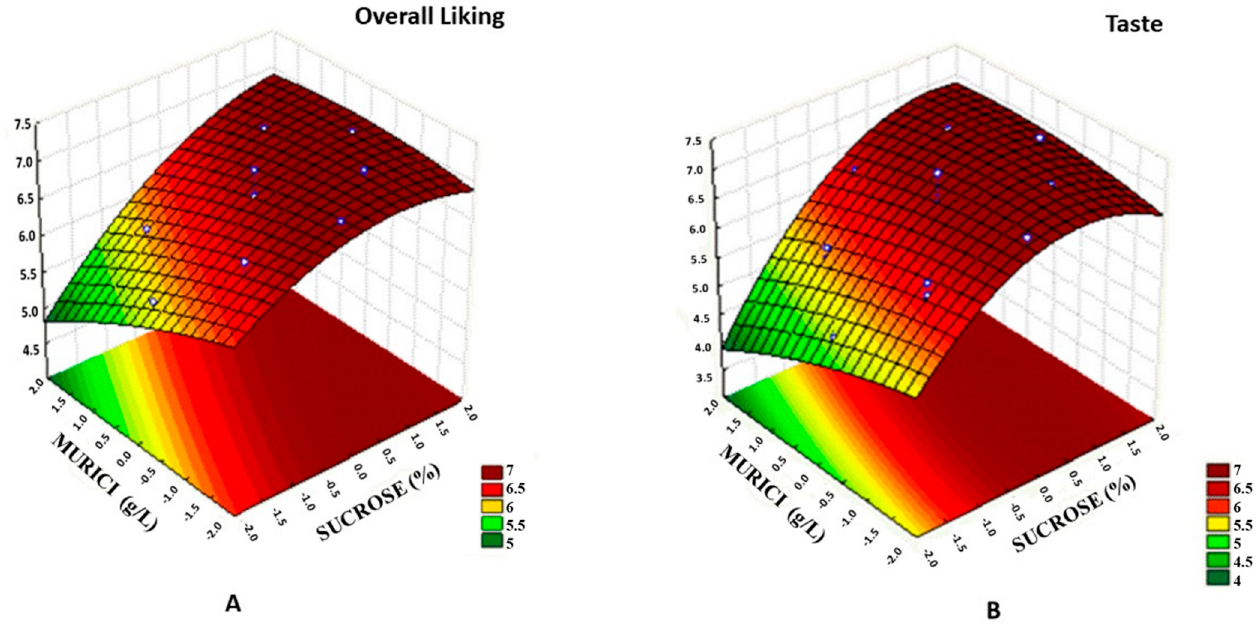
Figure 1. Response surface as a function of the murici pulp concentration and sugar concentration, with a concentration of 150 g/L of fixed taperebá pulp. ( A ) Overall liking attribute and ( B ) taste attribute.